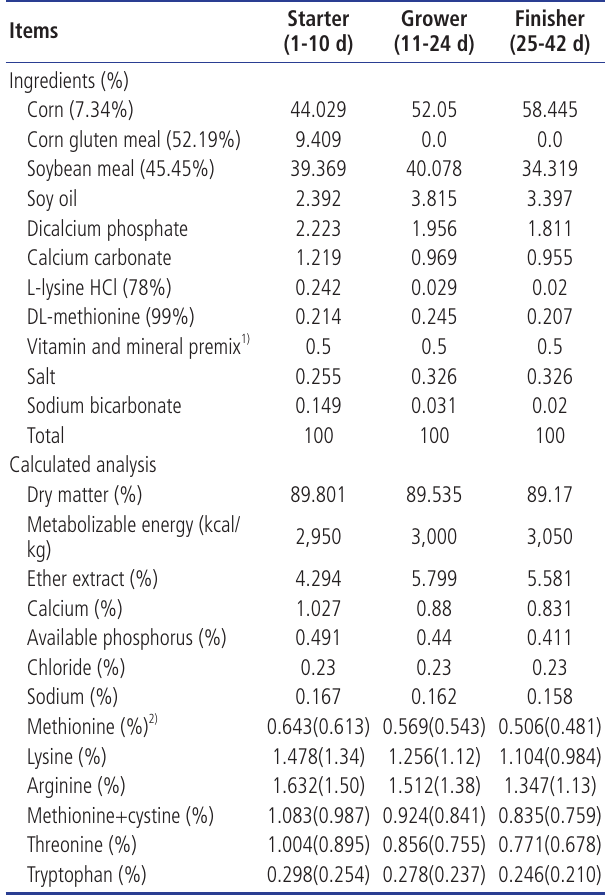
Table 1. Ingredient and chemical composition of basal